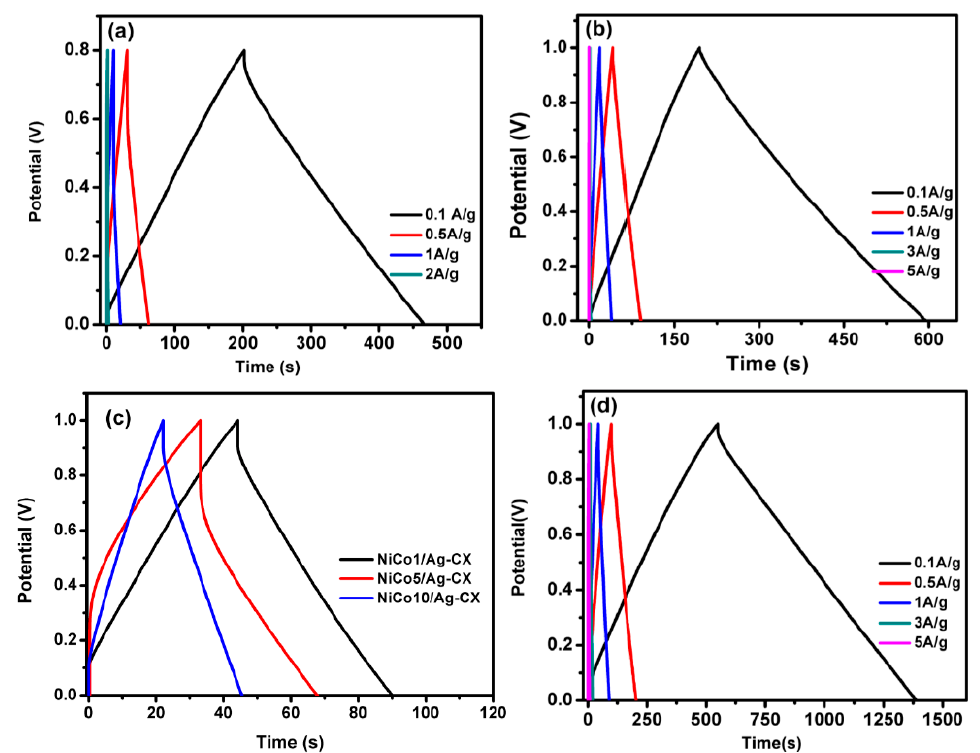
Figure 6. Charge / discharge curves for ( a ) CX at di ff erent current densities, ( b ) Ag-CX at di ff erent current Figure 6. Charge/discharge curves for ( a ) CX at different current densities, ( b ) Ag-CX at different densities, ( c ) NiCo1 / Ag-CX, NiCo5 / Ag-CX, and NiCo10 / Ag-CX at 1 A g − 1 , and ( d ) NiCo1 / Ag-CX at current densities, ( c ) NiCo1/Ag-CX, NiCo5/Ag-CX, and NiCo10/Ag-CX at 1 A g − 1 , and ( d ) NiCo1/Ag- CX at different current densities.